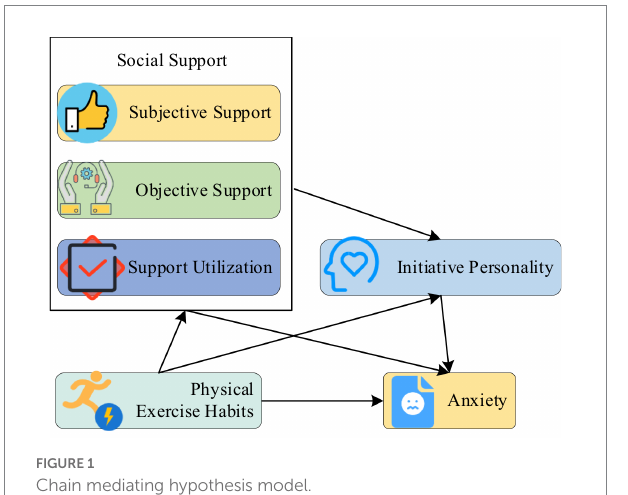
FIGURE 2 Gender distribution ( N =